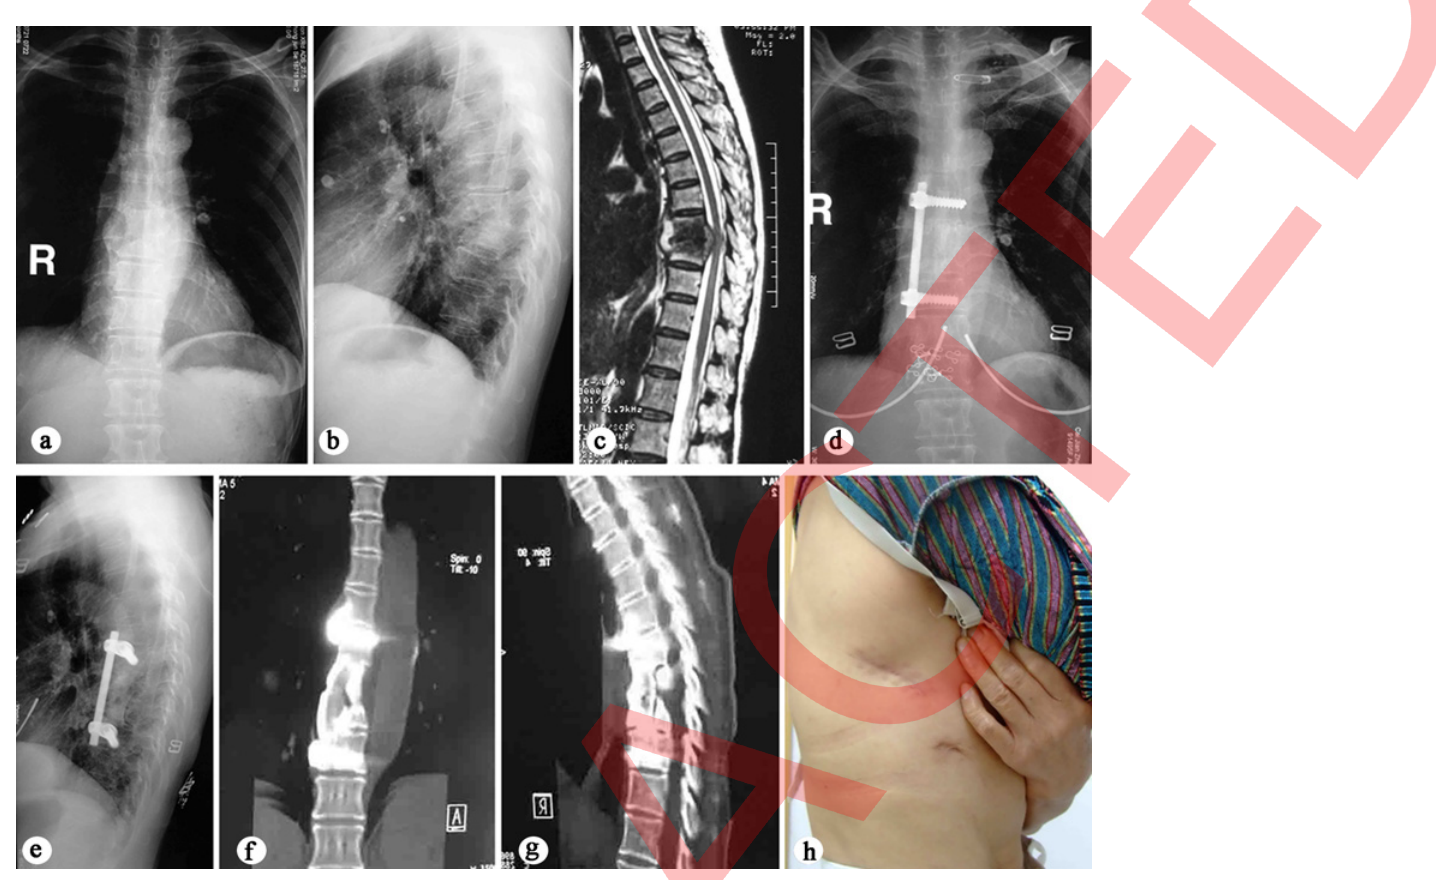
Fig 2. 53-year-old female with T8 – 9 tuberculosis underwent thoracoscopic-assisted anterior debridement, iliac bone autograft and instrumentation. Note the marked improvement of spinal stability and solid bone fusion when comparing her preoperative and latest films. a, b AP X-ray shows paraspinal shadow and lateral plain radiograph demonstrates a narrowed disc space at T8 – 9 and bone destruction of the T8 and T9 vertebral bodies. c MRI demonstrates vertebral destruction, paravertebral and epidural abscess with compression of the spinal cord. d, e X-ray films show graft union